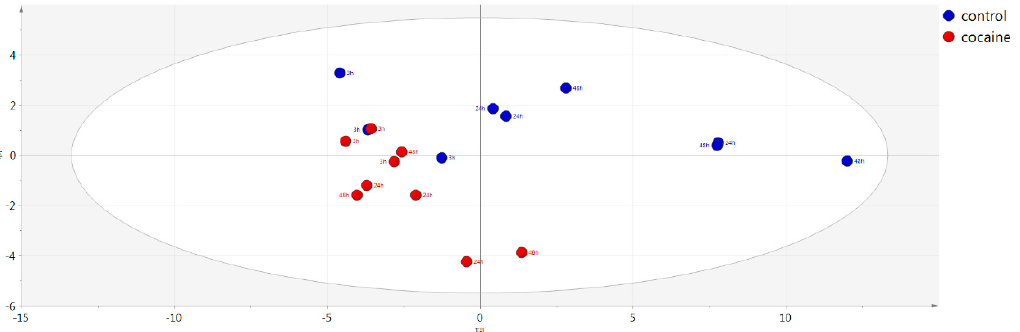
Figure 6. PCA model showing control (blue) vs. cocaine (red) treated intracellular material. Table 3. Model characteristics of PCA and OPLS-DA multivariate analysis.